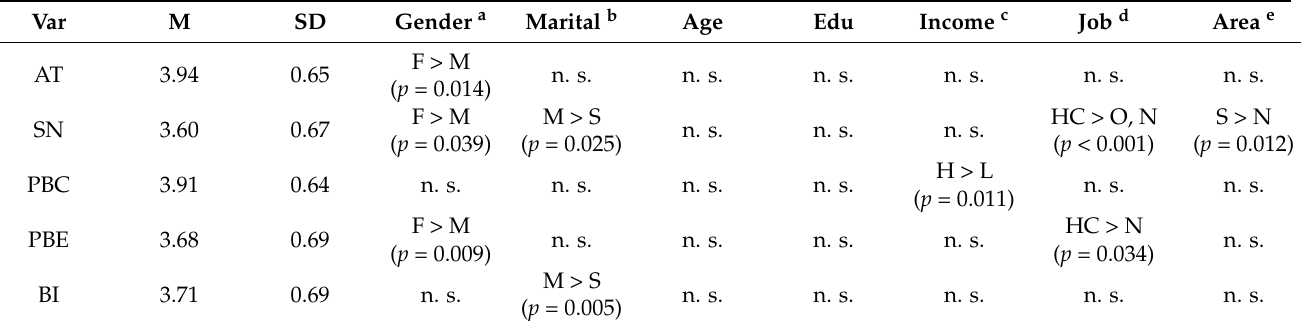
Table 2. Construct variance varied in gender, marriage, income, job, and